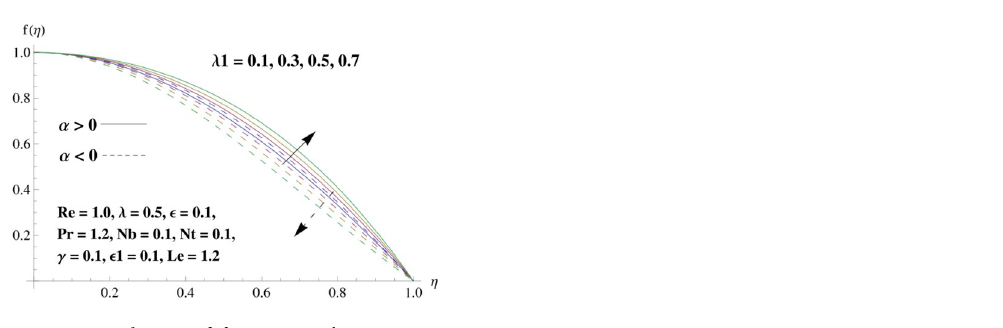
Figure 7. Behavior of f (η) against (cid:31) 1 .